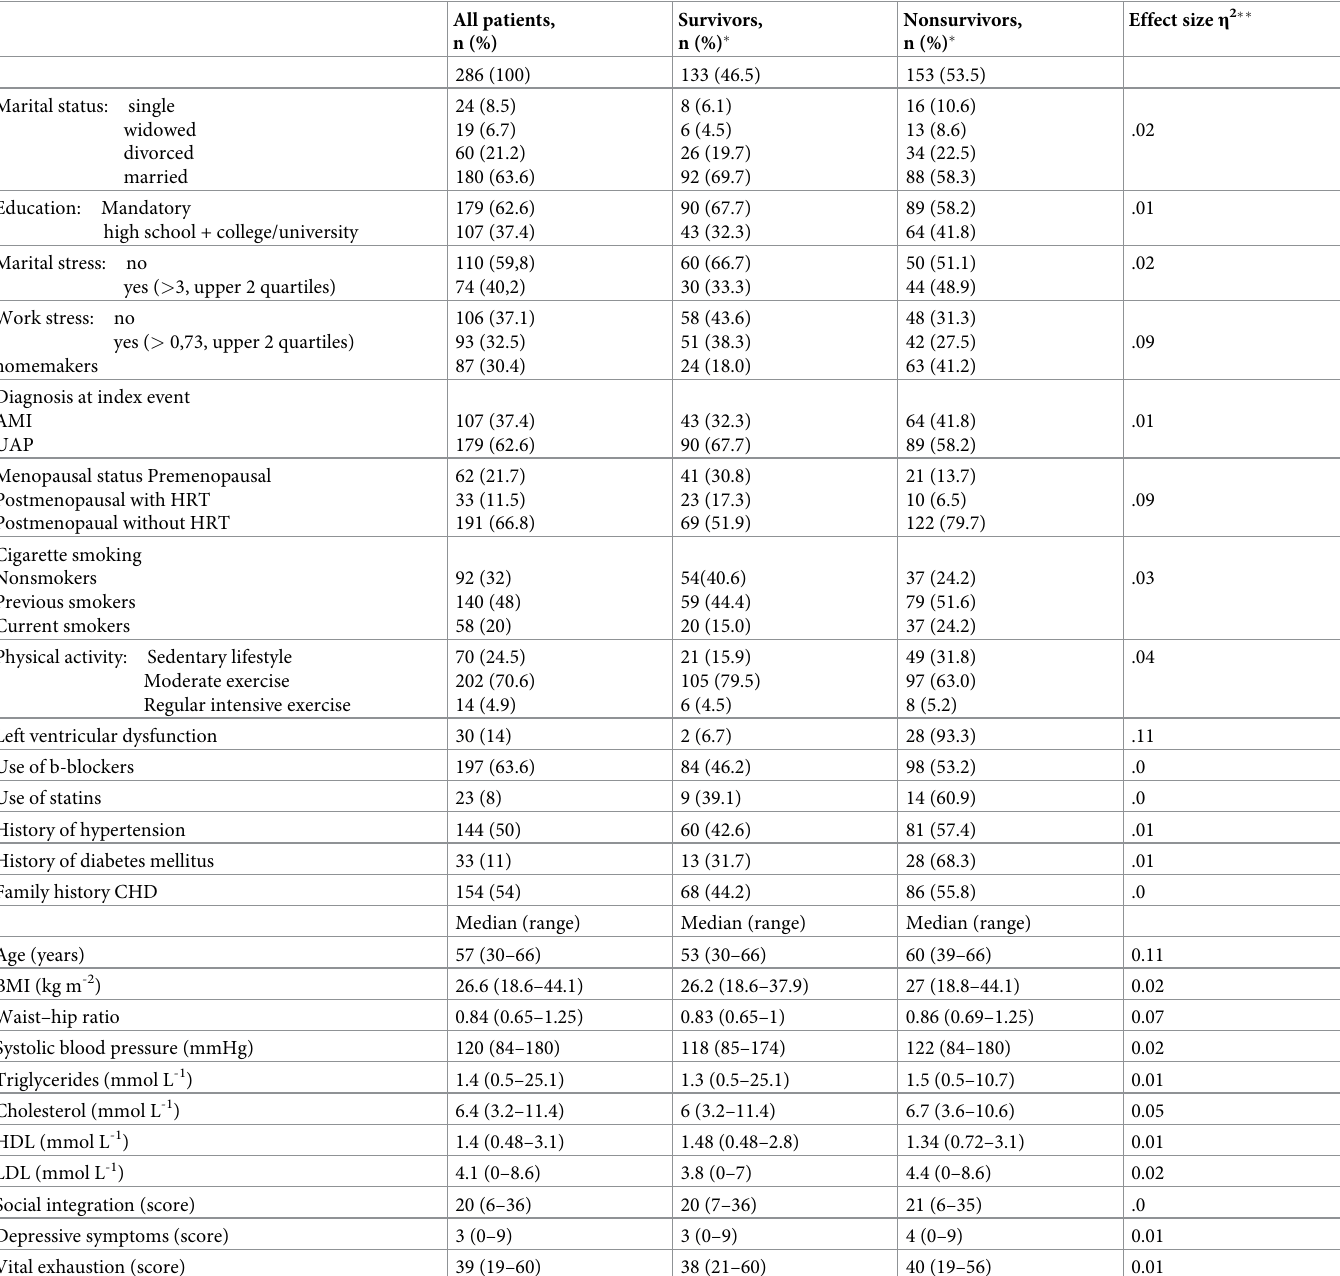
Table 1. Clinical, social and psychological characteristics of 286 female CAD patients at baseline and survival at 26 years follow-up.